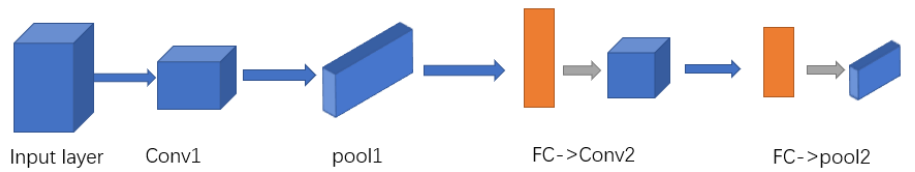
Figure 2. The structure of full convolution model.